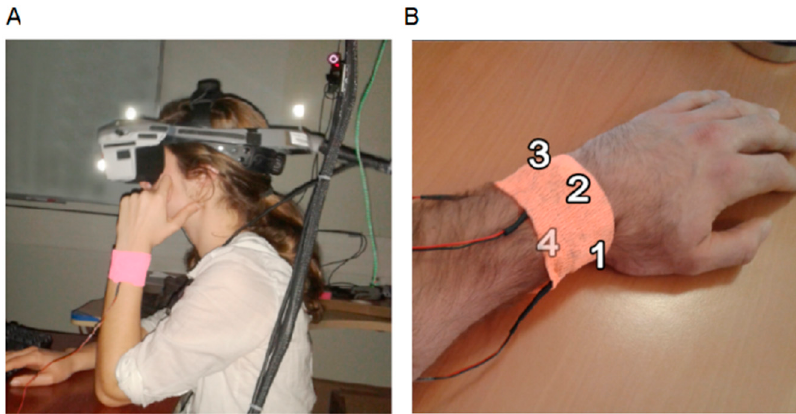
Figure 2. ( A ) Subject wearing the tactile display and a virtual helmet simulating tunnel vision. Head movements were tracked by a motion capture system. In the first experiment, subjects wore one vibrator placed on the wrist, and maintained by cohesive bandage. ( B ) During the experiments 2 and 3, four vibrators were placed on the left wrist. The fourth vibrator was placed on the anterior part of the wrist and is not visible here.